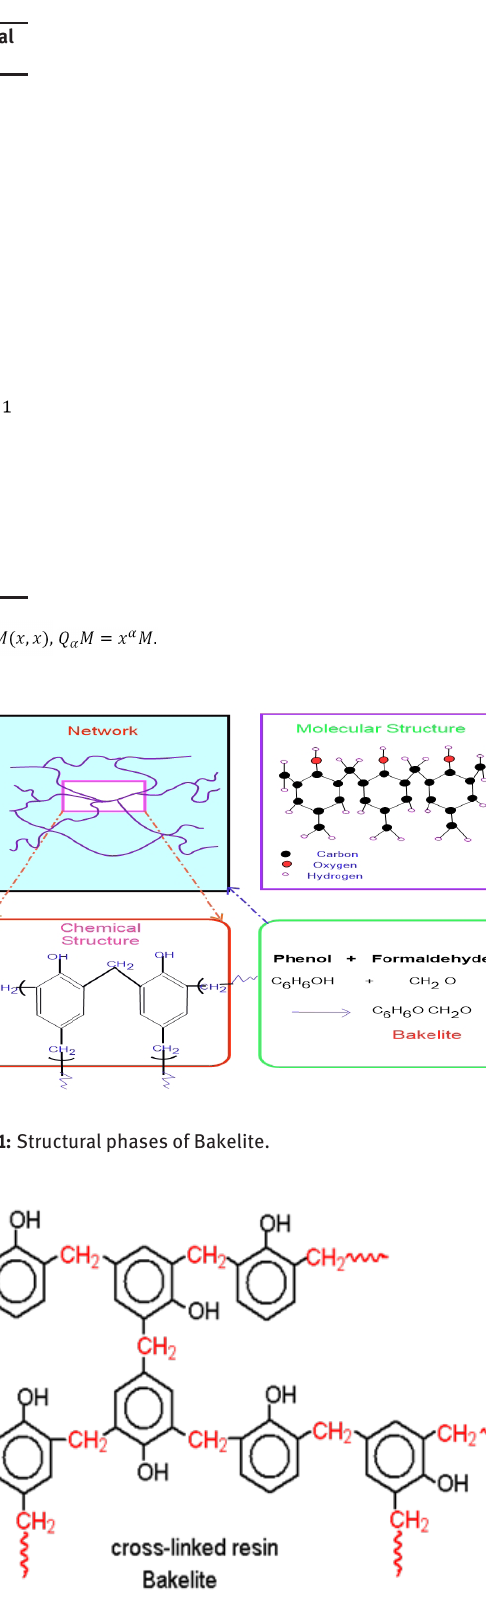
Table 1: Formulae of certain essential topological descriptors in relation with M-polynomial.